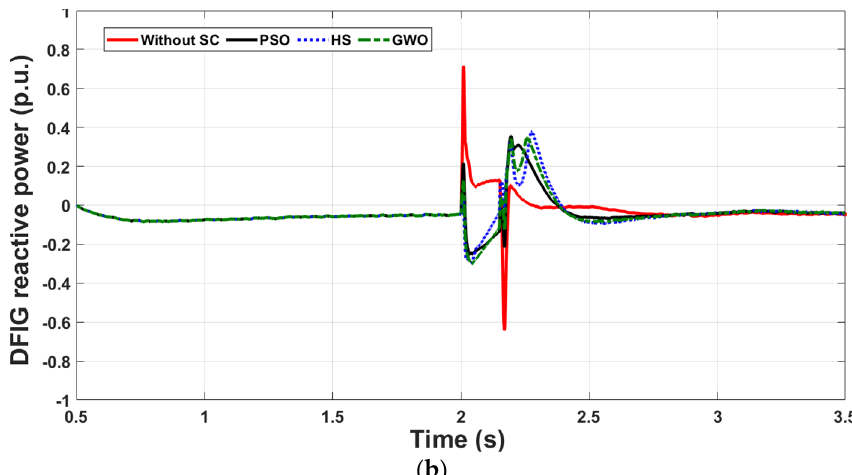
Figure 12. DFIG power during the three-phase fault case study ( a ) active power ( b ) reactive power. Table 2. Control sensitivity analysis.